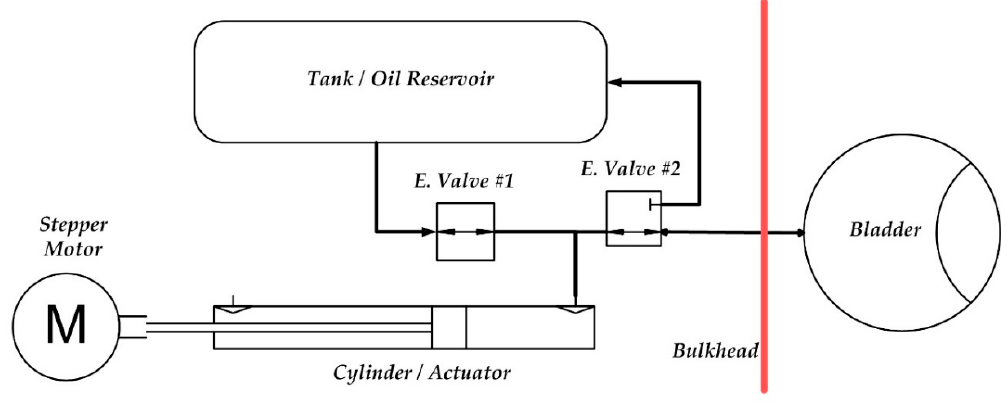
Figure 4. Basic scheme of the buoyancy system.